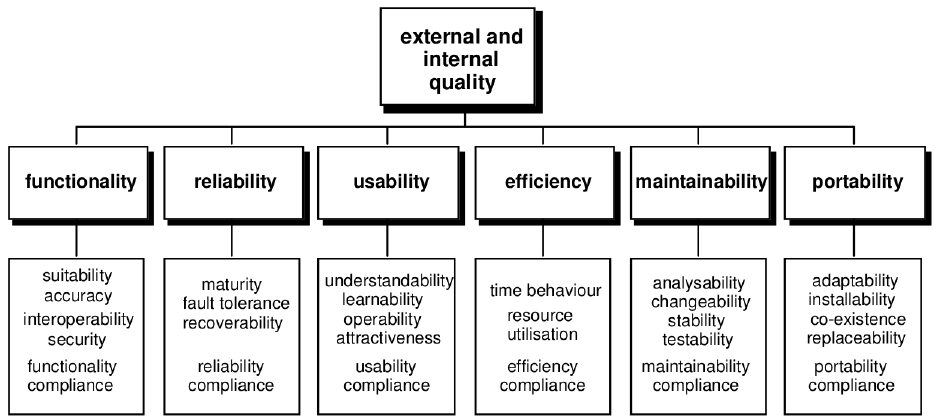
Figure 1. Quality model for external and internal quality